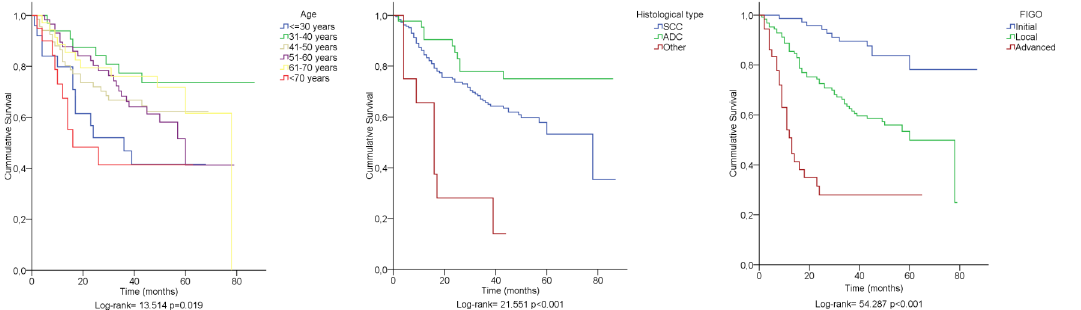
Fig 1. Kaplan-Meier survival curves stratified by age (left panel), clinical stage (middle panel) and histological type (right